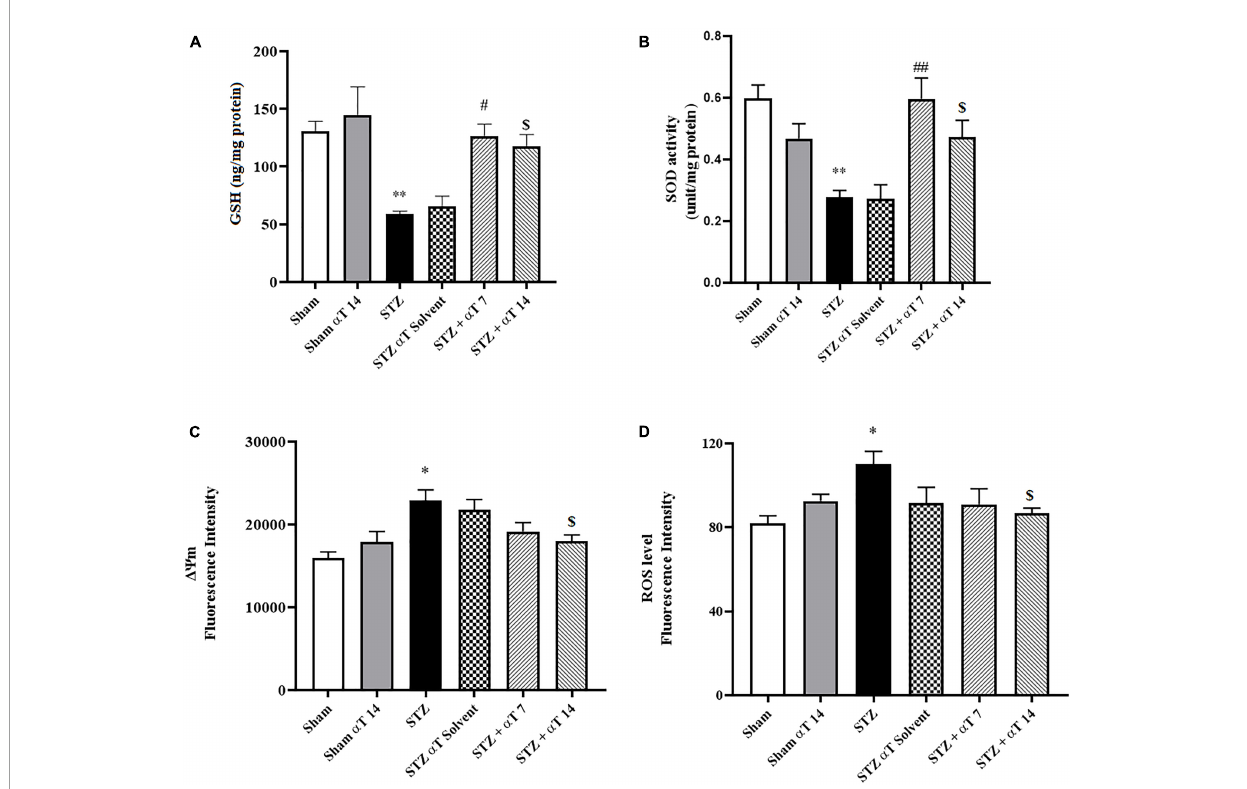
FIGURE4 Effect of α -Tocopherol therapy on stress oxidative and mitochondrial function. (A) The glutathione (GSH) content and (B) (SOD) the superoxide dismutase activity in the hippocampus homogenate significantly increased in the icv-STZ group in comparison with those of the sham and sham + α -Tocopherol group ( ∗∗ P < 0.01 in sham versus icv-STZ group) treatment with α -Tocopherol (STZ + α -Tocopherol 7 and STZ + α -Tocopherol 14) increased the GSH content by comparison with an icv-STZ group ( # P < 0.05 and $ P < 0.01, respectively). Treatment with α -Tocopherol also increased the SOD activity by comparison with the icv-STZ group ( ## P < 0.01 and $ P < 0.05, respectively), ( n = 5). (C) Increased Rh 123 fluorescence intensity in the icv-STZ group ( ∗ P < 0.05 compared to sham) decreased following α -Tocopherol post-treatment (STZ + α -Tocopherol 14) [ $ P < 0.05 compared to the icv-STZ group ( n = 5)]. (D) Increased ROS production in the icv-STZ group ( ∗ P < 0.05 compared to sham) decreased following α -Tocopherol post-treatment (STZ + α -Tocopherol 14) ( $ P < 0.05 compared to the icv-STZ group). All graphs were plotted as mean ± SEM ( n =